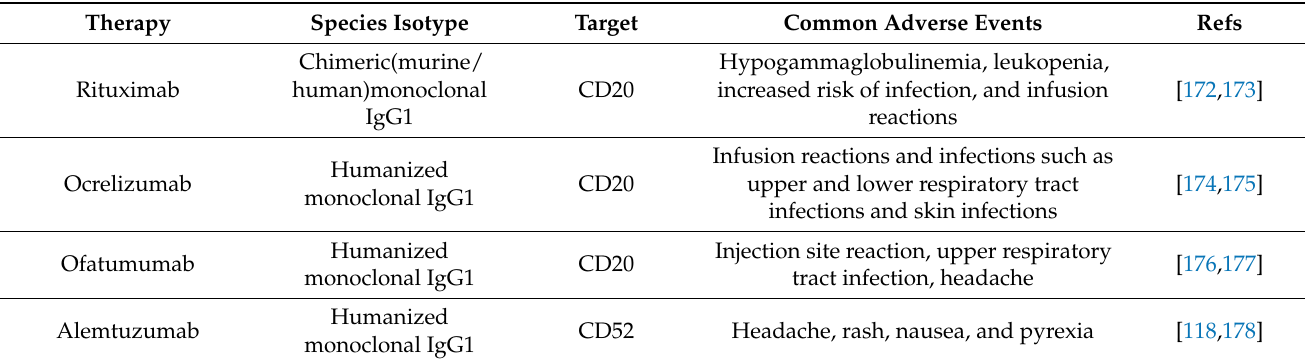
Table 3. Monoclonal antibodies that target B